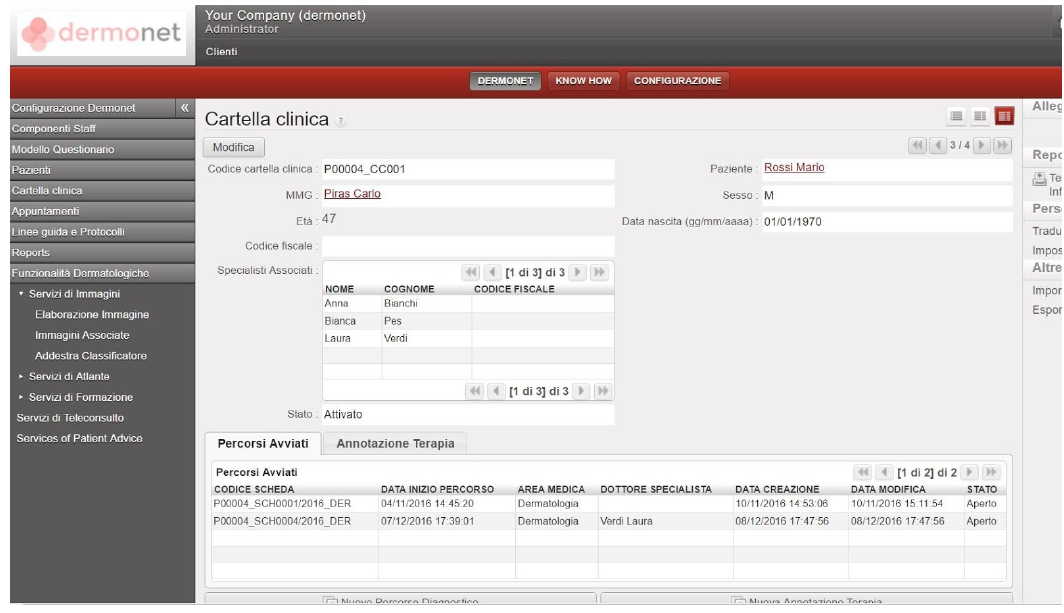
Figure 1. Patient medical record.